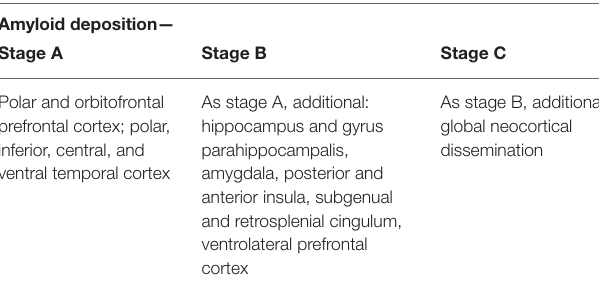
TABLE 3 | Stages of amyloid deposition (Braak and Braak, 1991, 1997; Braak et al.,